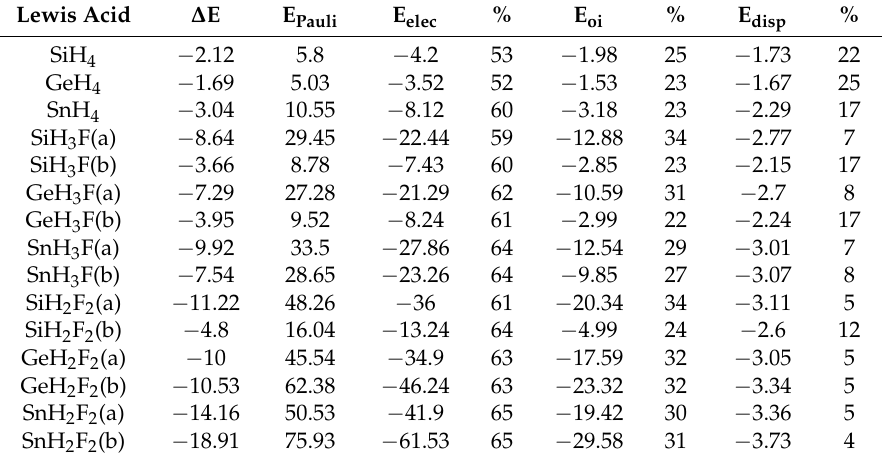
Table 5. EDA/BLYP-D3(BJ)/ZORA/TZ2P decomposition of the interaction energy of σ -hole bonded complexes into Pauli repulsion (E Pauli ), electrostatic (E elstat ), orbital interaction (E oi ) and dispersion (E disp ) terms. All energies in kcal mol − 1 . The relative values in percent express the contribution of each to the sum of all attractive energy